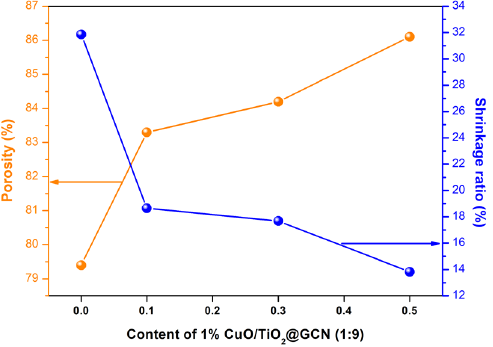
Figure 6. The plot of porosity and shrinkage ratio concerning the content of the dopant nanocomposite (1% CuO/TiO 2 @GCN (1:9)).